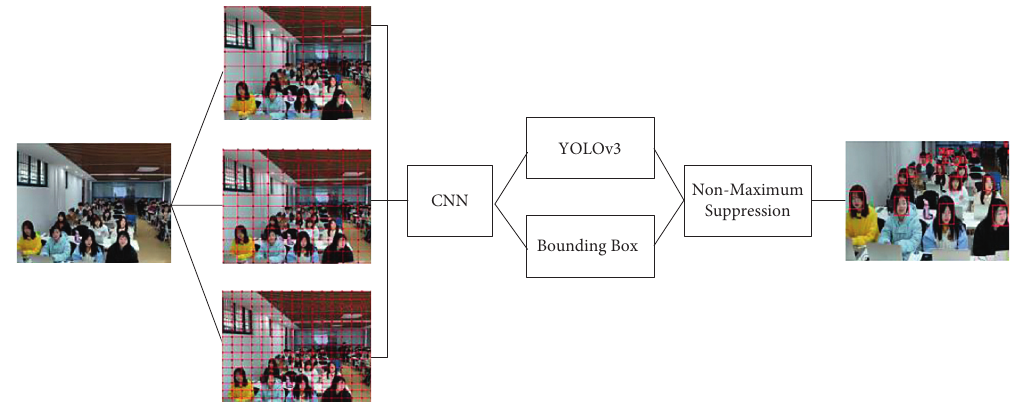
Figure 1: Process of YOLO face